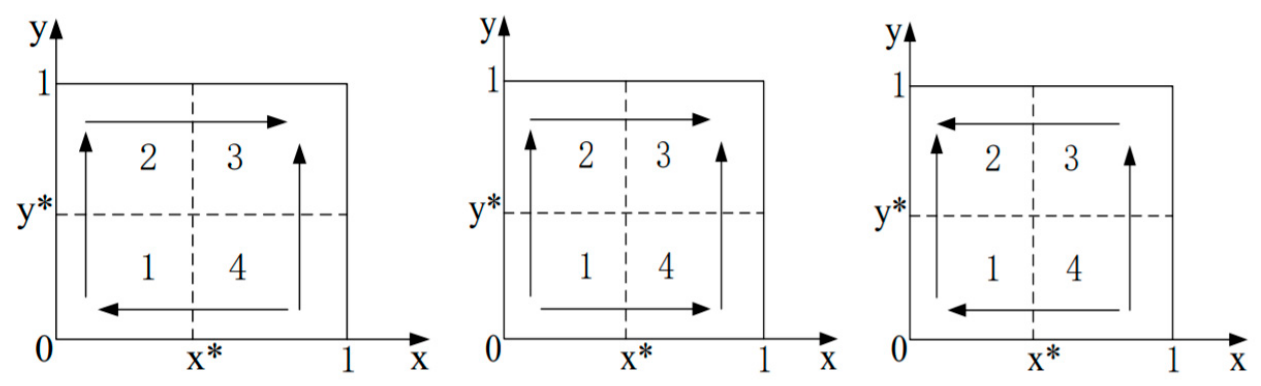
Figure 6. Replicating the dynamic phase diagram at the mature stage.